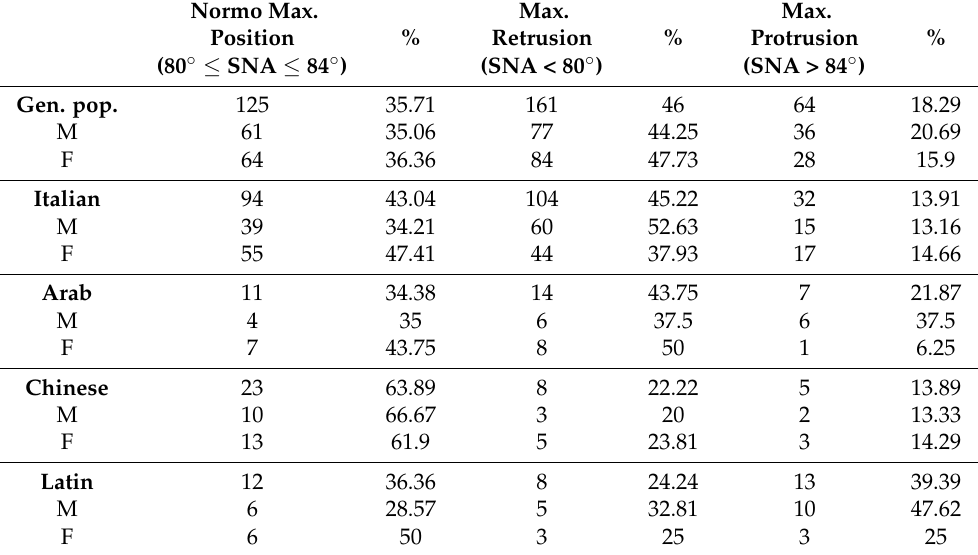
Table 4. Distribution of the position of the maxillary bone in the selected patient